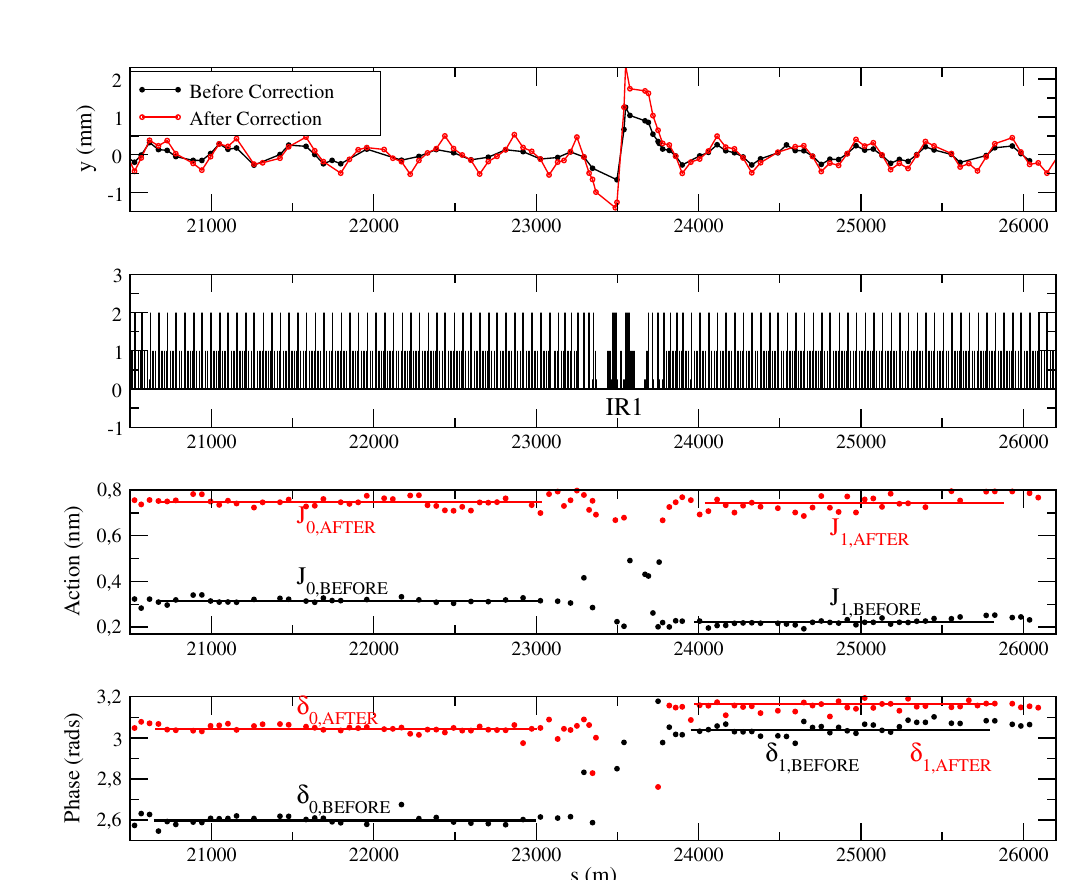
FIG. 1. Action and phase analysis of 2015-LHC beam trajectories. Each point of the action and phase plots is calculated with measurements of two adjacent Beam Position Monitors (BPMs) (see [6]) that have been preprocessed with averaging techniques, as explained in Sec. V. The figure also contains a simplified representation of the LHC lattice with short bars corresponding to dipole magnets and long bars corresponding to quadrupole magnets. The effect that local corrections have on the action and phase plots is also